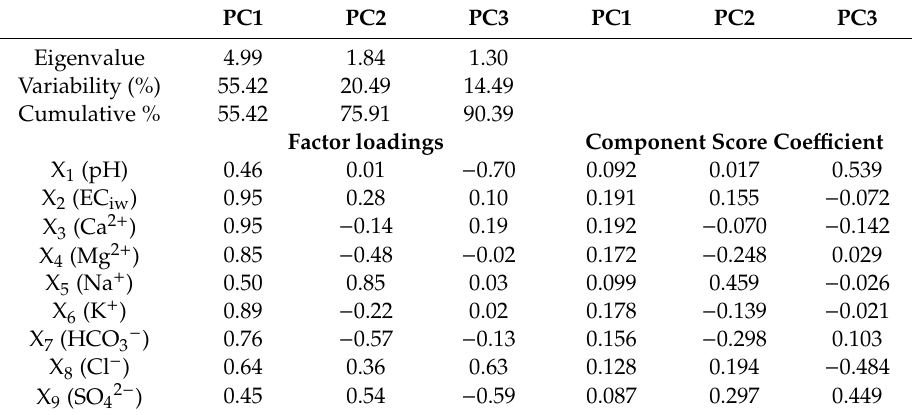
Table 1. Summarization of the principal component analysis